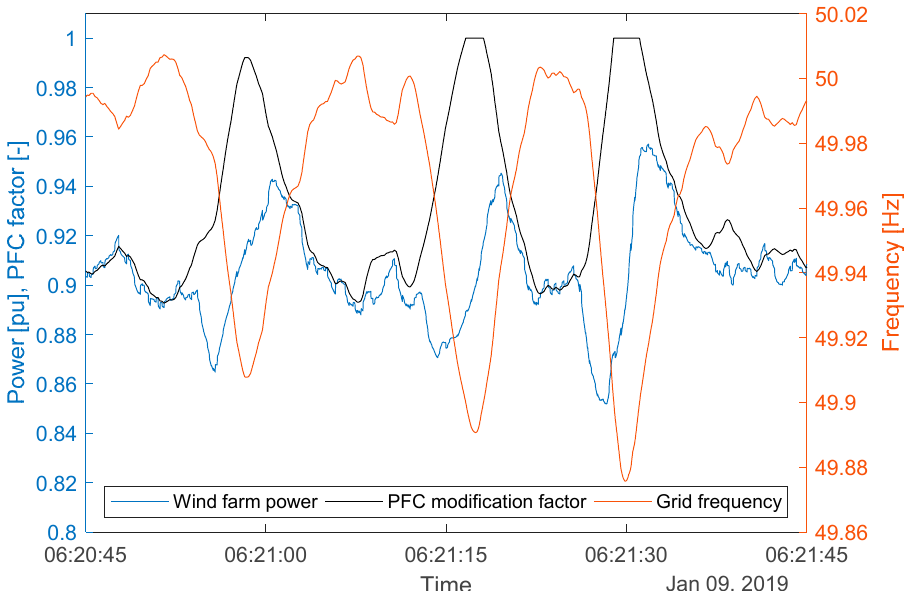
Figure 15. Results of scenario III: Wind farm power (pu base = 10 MW), PFC modification factor η PFC , and grid frequency during negative wind gusts.